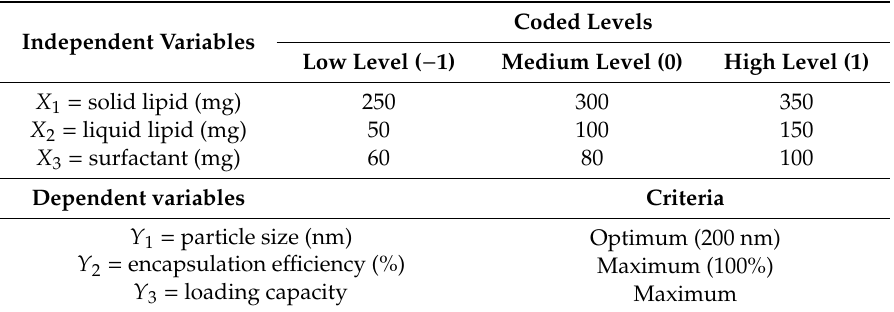
Table 1. Independent and dependent variables of the 3-level, 3-factor Box–Behnken design. Independent